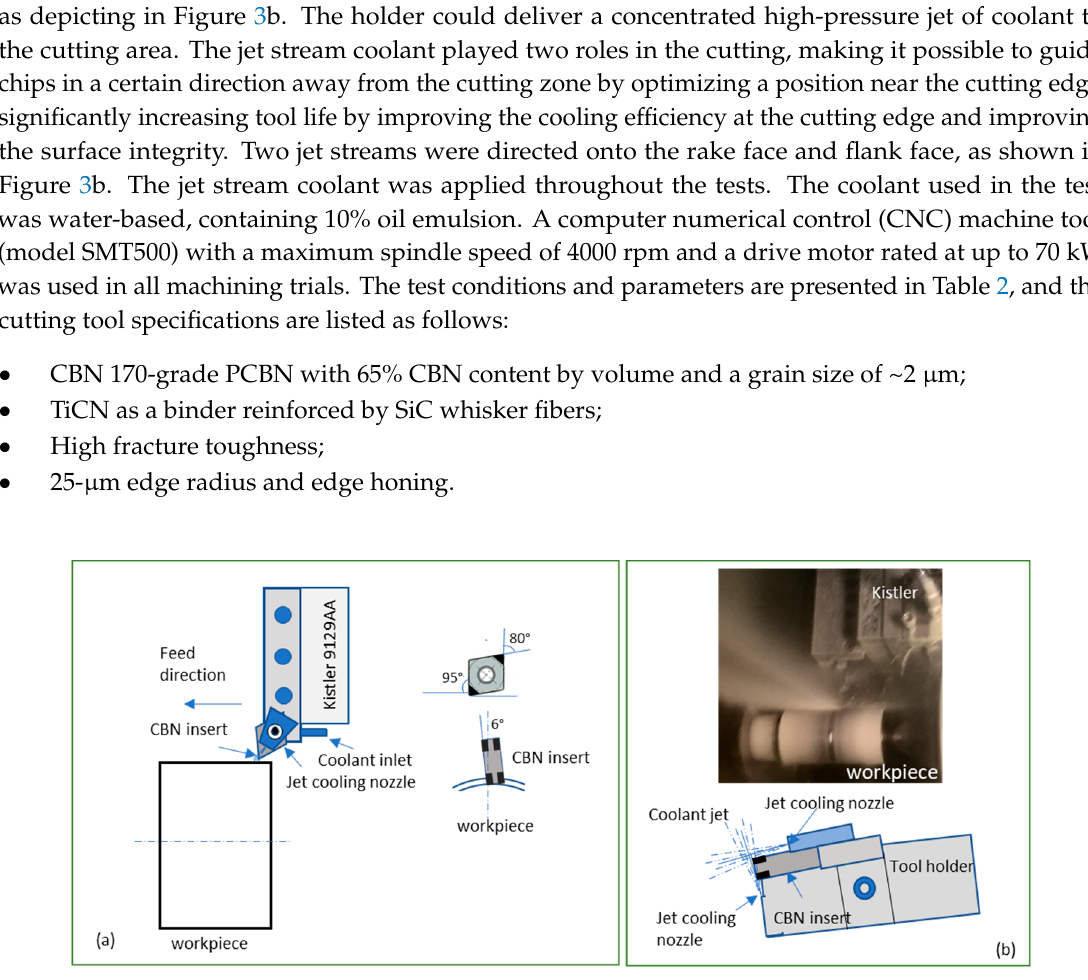
Table 2. Test conditions and parameters. CBN: cubic boron nitride.